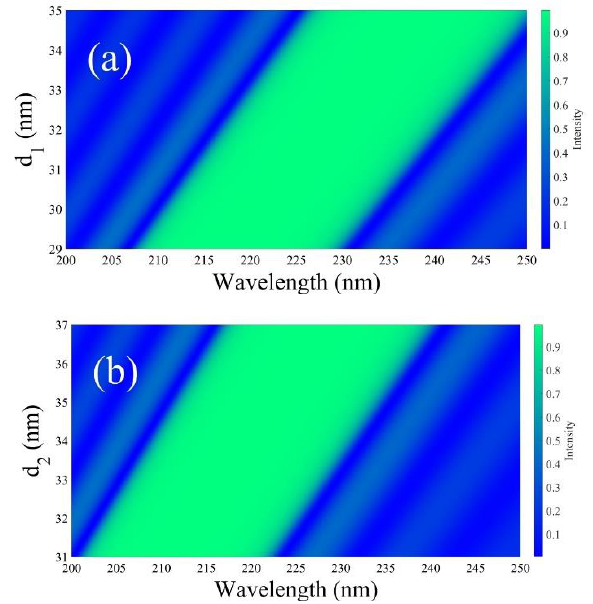
Figure 4. The influence of altering the thicknesses of the unit cell’s layers on the structure reflectivity; ( a ) the thickness of Al 2 O 3 ; ( b ) the thickness of S i O 2 .